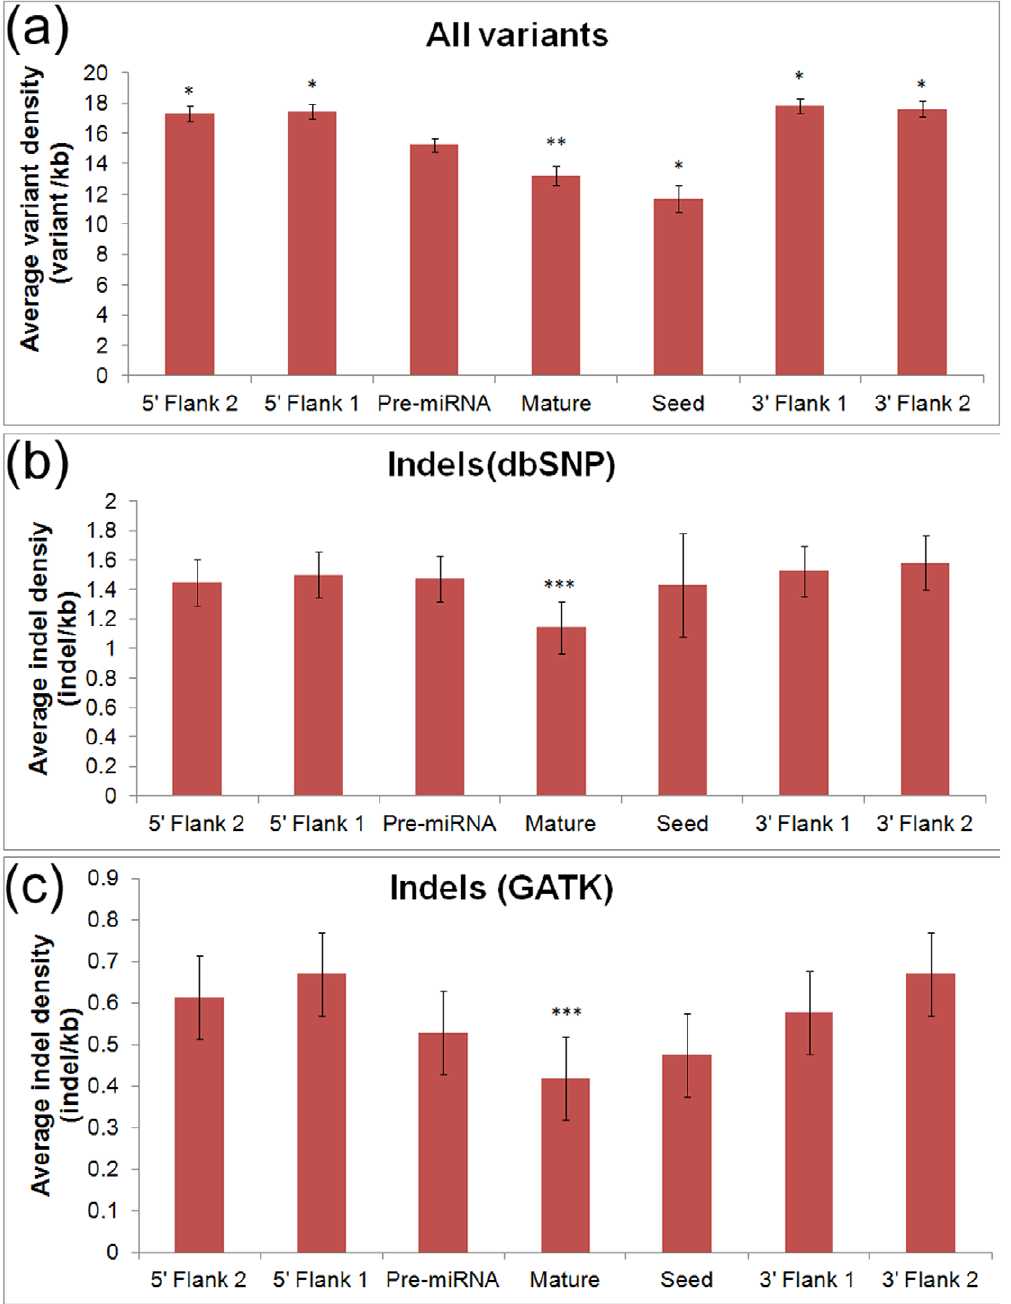
Figure 1. Density of all genetic variants (a) and indels (b) in dbSNP 135 as well as indels (c) from the GATK resource bundle in pre- miRNAs, mature miRNAs, miRNA seed regions, and flanking regions. Flanking regions 1 and 2 represent successive sequences adjacent to pre-miRNAs that were equal to the length of the pre-miRNA ( , 100 bp). Error bars indicate the standard error. The density of all genetic variants (a) in pre-miRNAs was significantly different from the density in flanking regions, mature miRNAs, and seed regions (*p , 0.01, **0.01 , p , 0.05). The density of indels in mature sequences (b) and (c) was significantly different than the density calculated by averaging across all four flanking regions (***0.01 , p ,